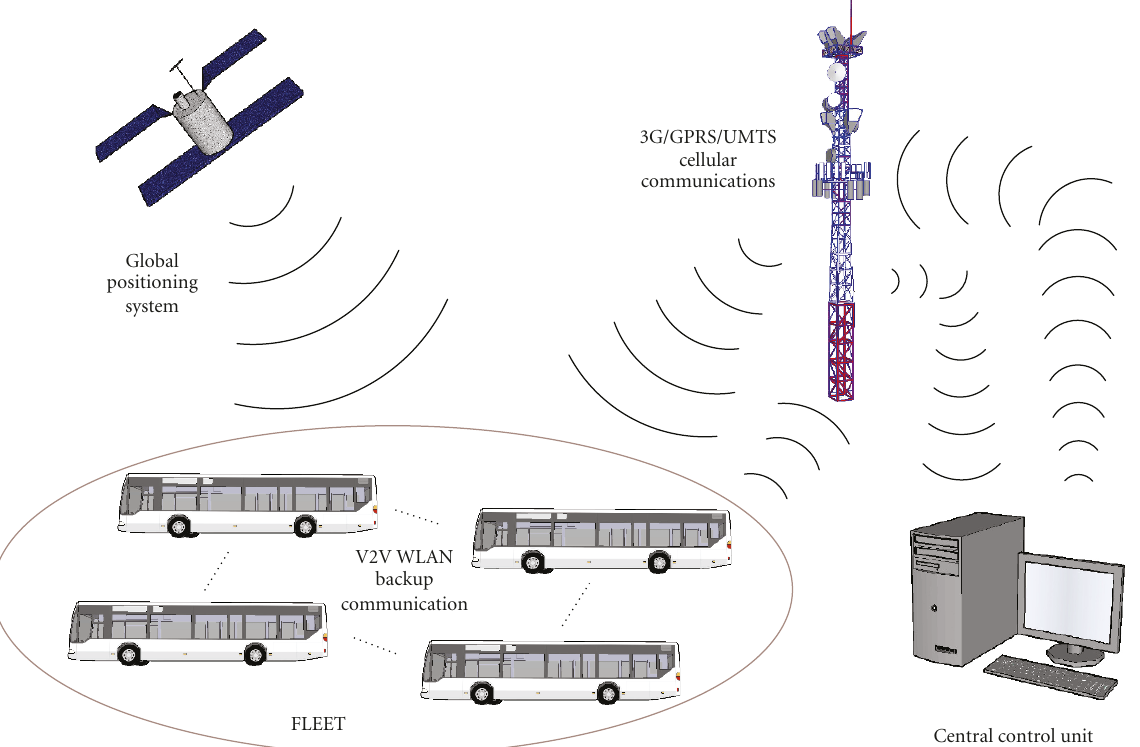
Figure 1: Overview of the proposed FCD